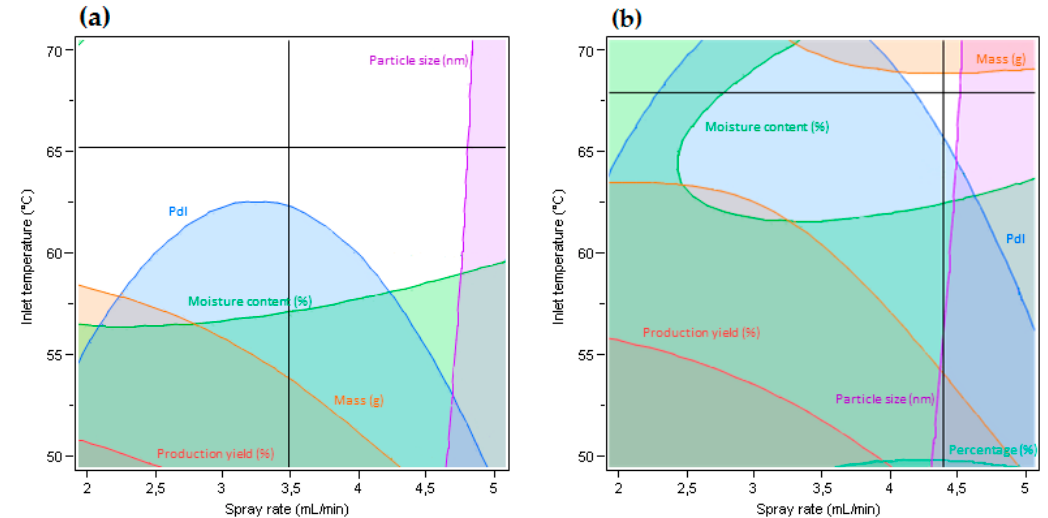
Figure 2. Contour plot function for determining ranges of settings for two selected factors (uncolored space) in order to obtain desired values of responses. ( a ) Production yield ≥ 30 %, moisture content ≤ 8%, polydispersity index ≤ 0.8, mass ≥ 0.6 g, percentage ≥ 30 %, microparticle diameter ≤ 3500 nm; ( b ) production yield ≥ 40 %, moisture content ≤ 7%, polydispersity index ≤ 0.7, mass ≥ 0.7 g, percentage ≥ 40 %, microparticle diameter ≤ 3000 nm).